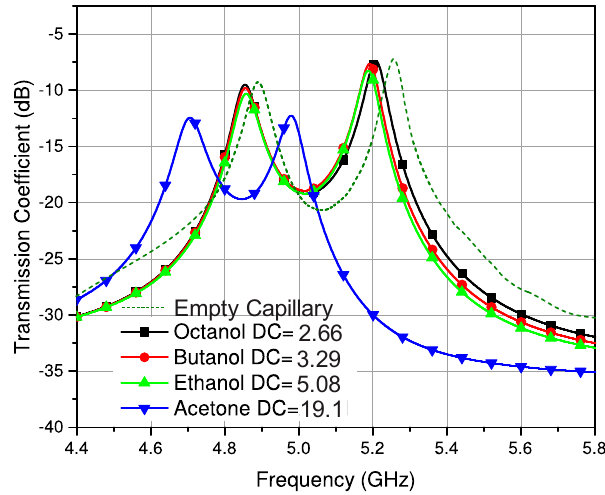
Figure 7. Response of filter with the horizontal orientation of the LUT.